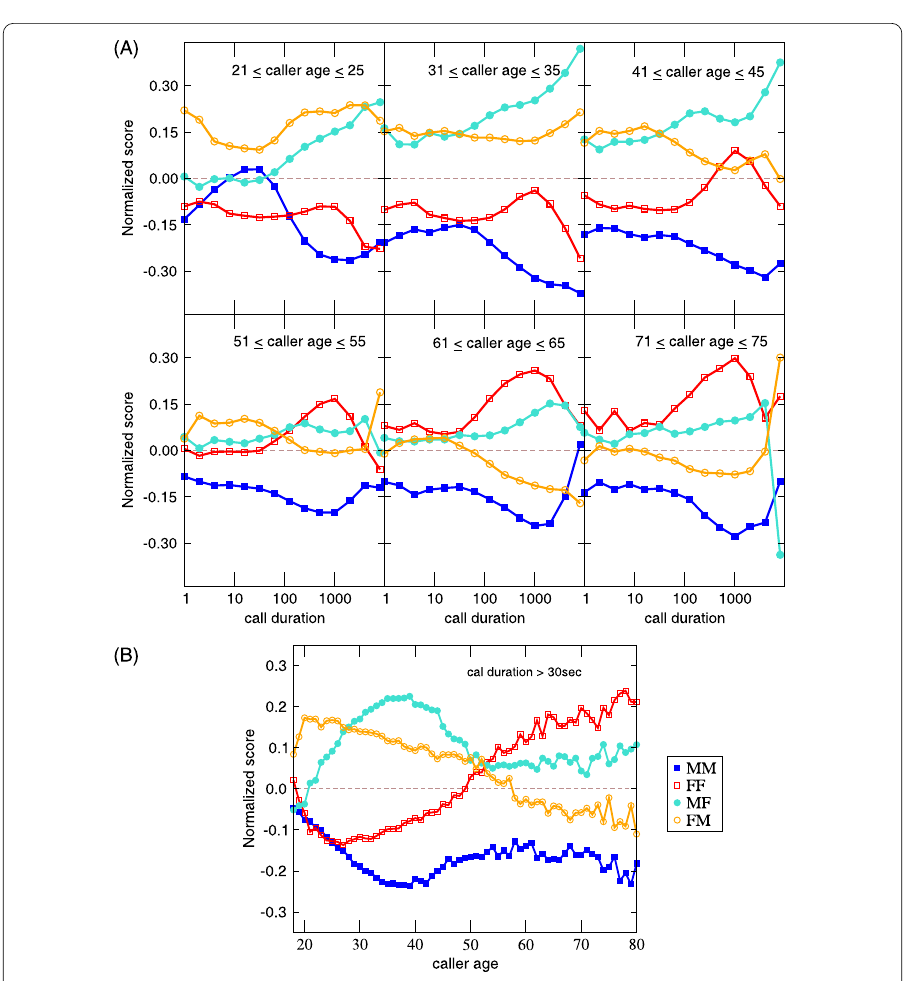
Figure 6 The null model is used to obtain normalized scores that correspond to the results shown in Fig. 2 and Fig. 3. ( A ) The scores plotted are adjusted values for communication probabilities f MM ( g , t ), f FF ( g , t ), f MF ( g , t ), and f FM ( g , t ) shown in Fig. 2, and are obtained using equations similar to Eq. (3) (for FF pairs). ( B ) The scores correspond to results shown in Fig. 3